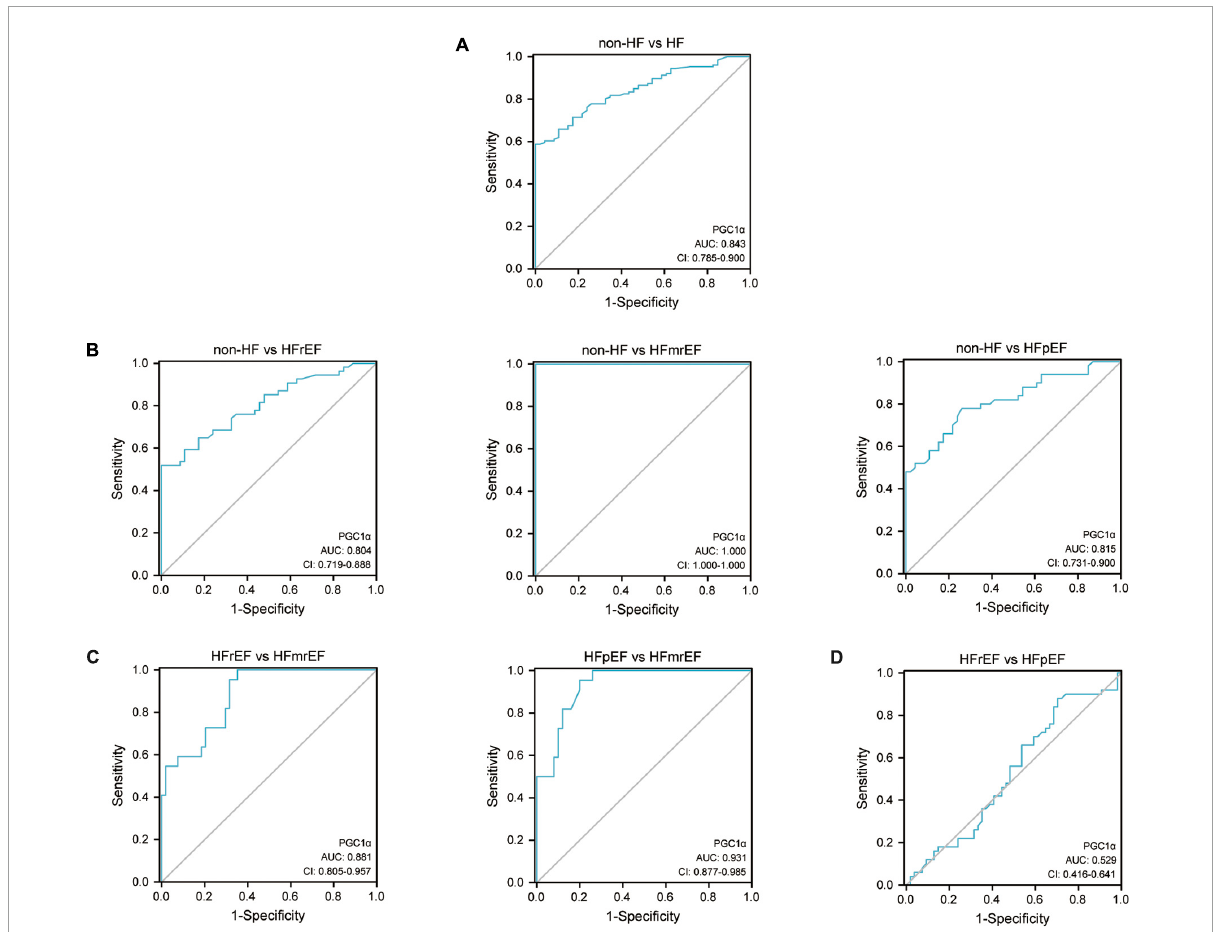
FIGURE3 ROC curve of PGC1 α in diagnosing HF phenotypes. (A) The ROC curve of PGC1 α in diagnosing HF compared with non-HF. (B) The ROC curve of PGC1 α in identifying various HF phenotypes compared with non-HF. (C) The ROC curve of PGC1 α in distinguishing HFmrEF from the other two HF phenotypes. (D) The ROC curve regarding the comparison of PGC1 α between HFrEF and HFpEF. ROC, receiver operating characteristic; AUC, area under the curve; CI, confidence interval; PGC1 α , peroxisome proliferator-activated receptor- γ coactivator-1 α ; HF, heart failure; HFrEF, heart failure with reduced ejection fraction; HFmrEF, heart failure with mildly reduced ejection fraction; HFpEF, heart failure with preserved ejection fraction.